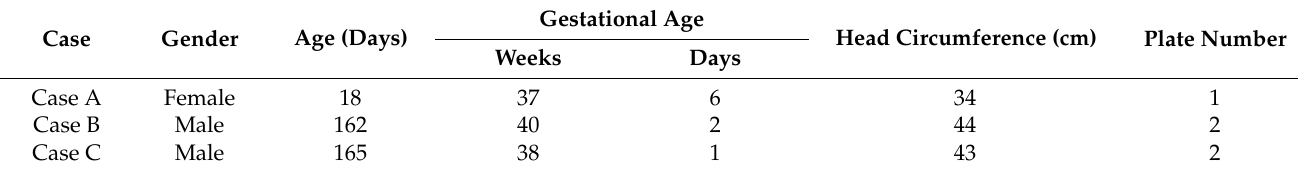
Table 2. Clinical picture of three different patients (case A–C) receiving TPP treatment.